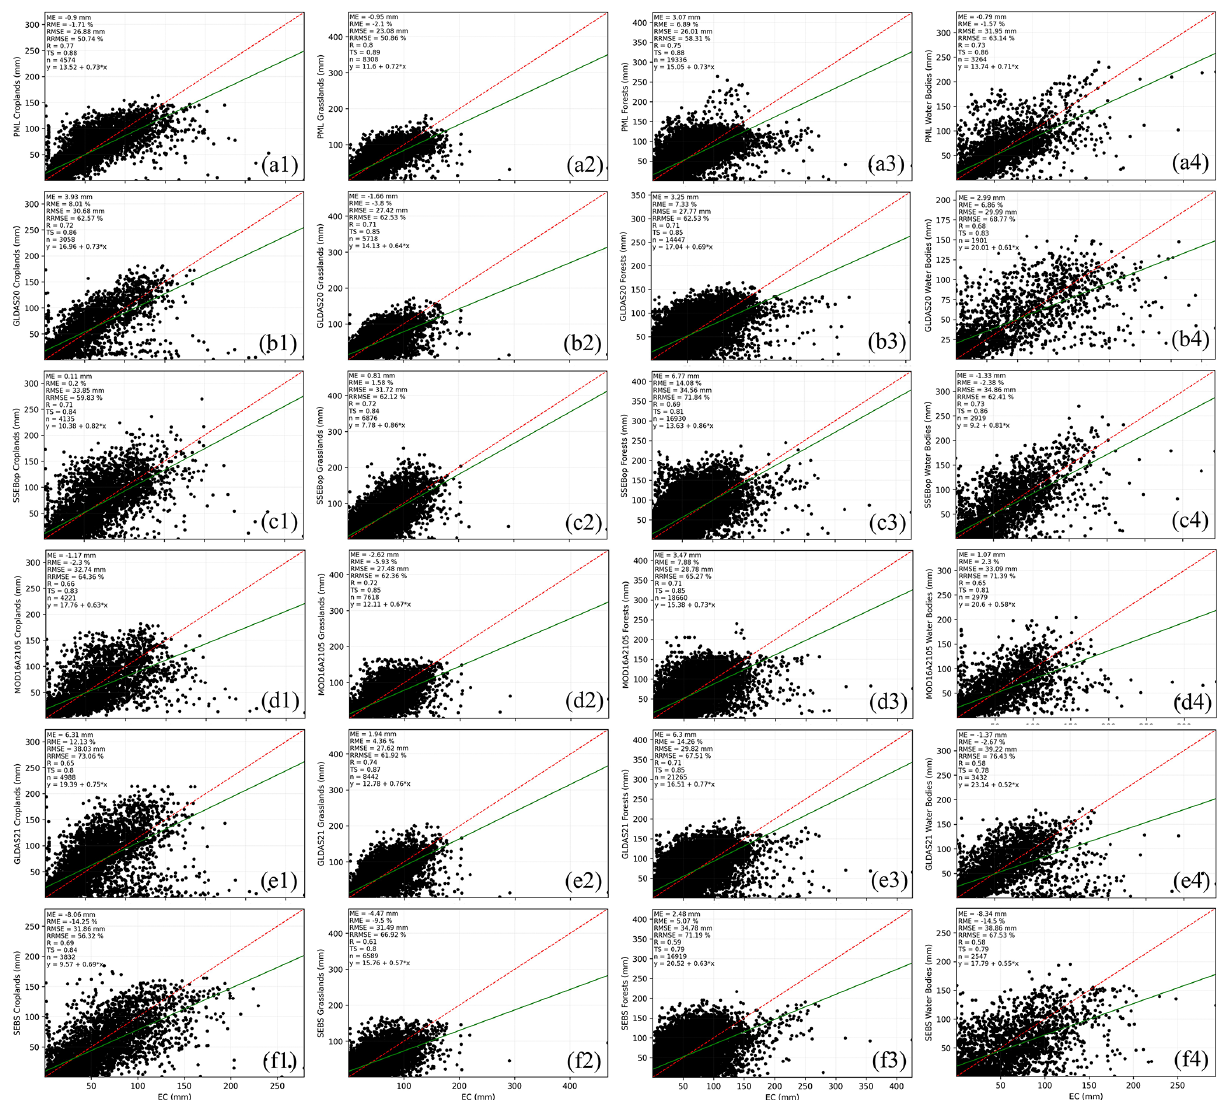
Figure 7. Monthly ET products (PML: a ; GLDAS20: b ; SSEBop: c ; MOD16A2105: d ; GLDAS21: e ; SEBS: f ) against flux EC ET aggre- gated for all sites for each land cover type (croplands: 1; grasslands: 2; forests: 3; water bodies: